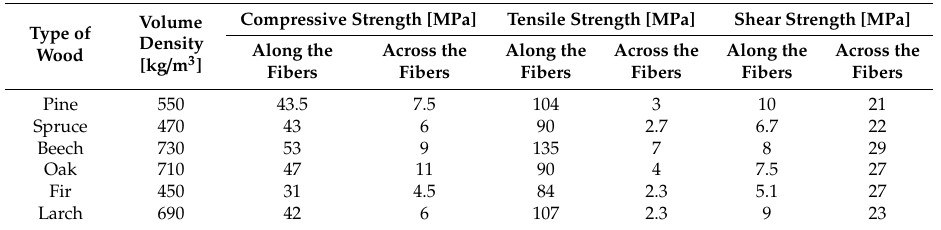
Table 1. Basic strength parameters for various types of wood commonly used in Polish underground mines, based on